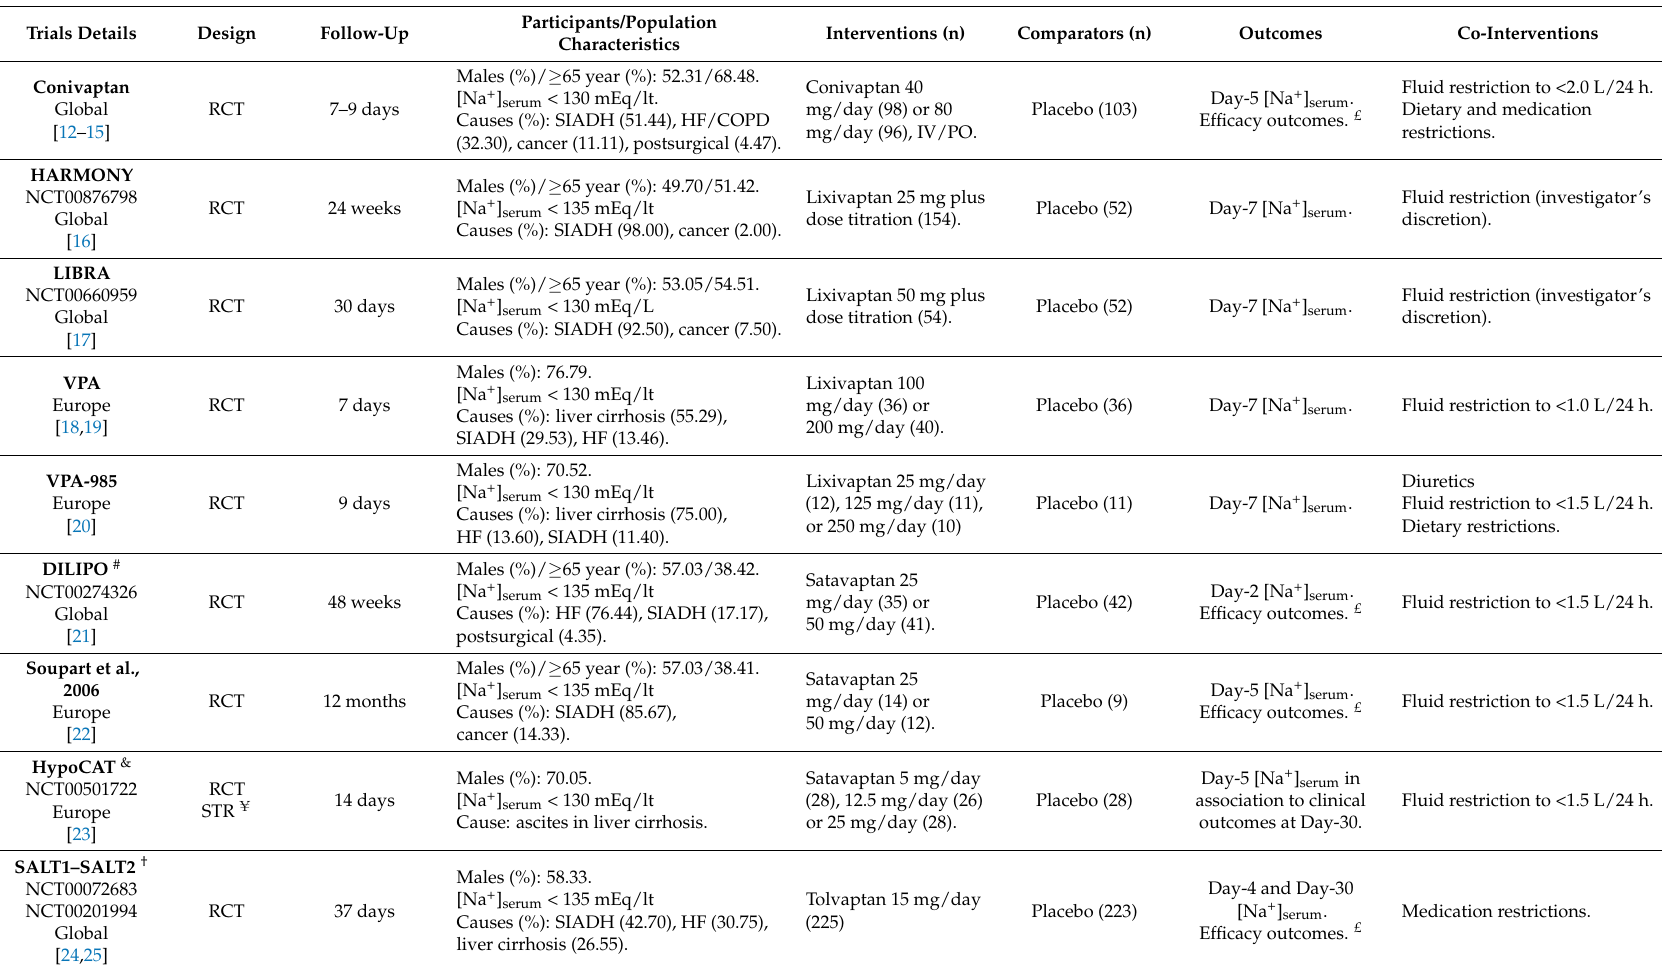
Table 2. Participants, interventions, comparators and outcomes in eligible